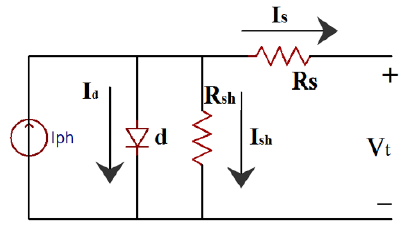
Figure 1. Single diode model.